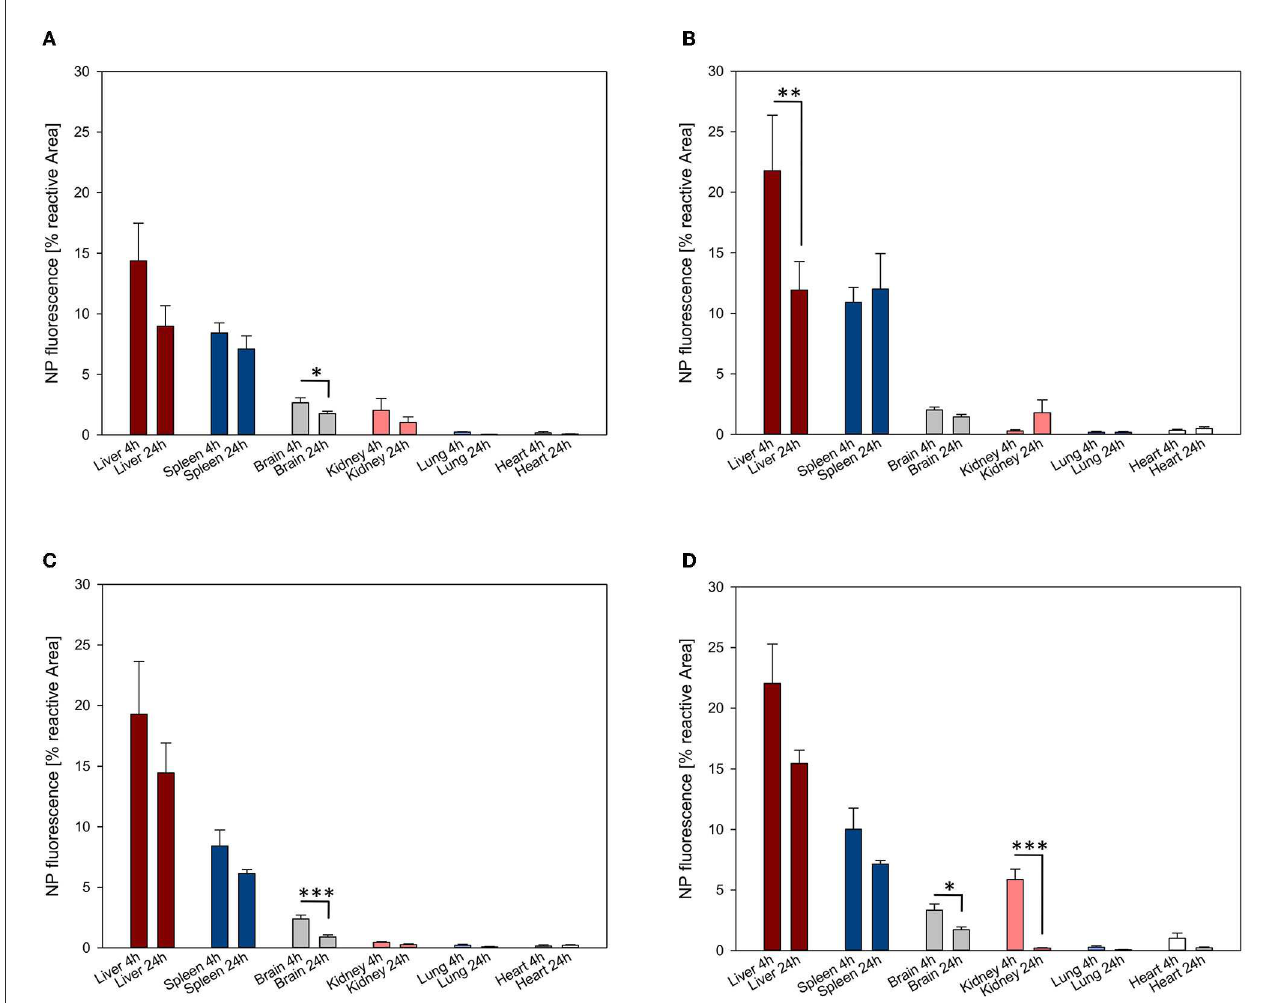
FIGURE5 NP uptake kinetics assessed at 4 and 24h in the liver, spleen, brain, kidney, lung and heart. The accumulation of PFDL-Tw (A) , PFDL-SDS (B) , PLLA-Tw (C) , and PLLA-SDS (D) nanoparticles was assessed as the percentage of reactive fluorescent area in relation to the total area of the ROI at 40 × magnification. Paired t -tests were used for comparing NP uptake at both study time points for each organ, showing in general a trend to decay in NP accumulation after 24h. Bars express means ± SEM. *** p < 0.001, ** p < 0.01, * p <